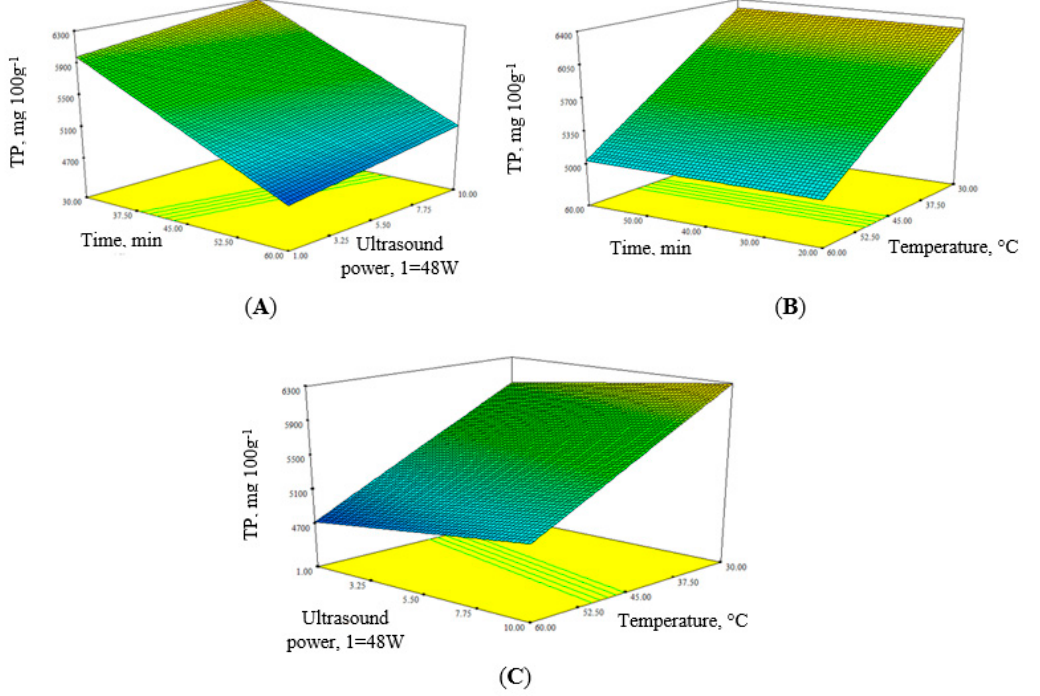
Figure 1. Response surfaces plots for total phenols (TP) in Japanese quince fruit, in the function of ultrasound power, extraction time, and temperature. ( A )—Extraction time and ultrasound power; ( B )—extraction time and temperature; ( C )—extraction temperature, and ultrasound power.